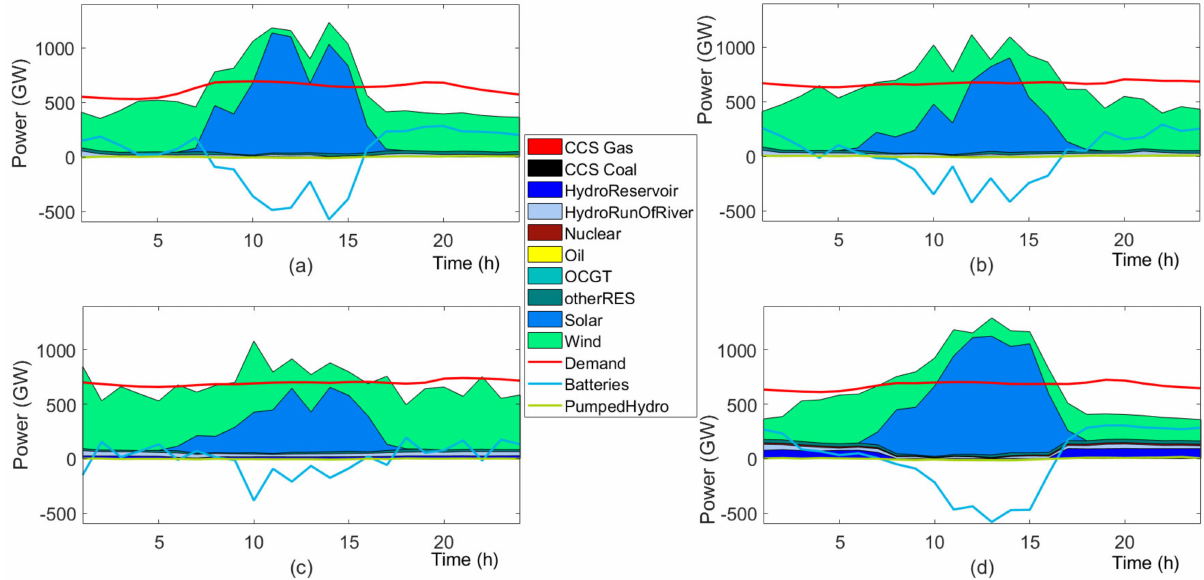
Figure 10. Generation mix in the year 2050 according to scenario 1 (i.e., scenario-tree node 8), with the availability of storage, in four typical days. Figure ( a ) reports a typical day within the period January–March, ( b ) a typical day within April–June, ( c ) a typical day within July–September, and ( d ) a typical day within